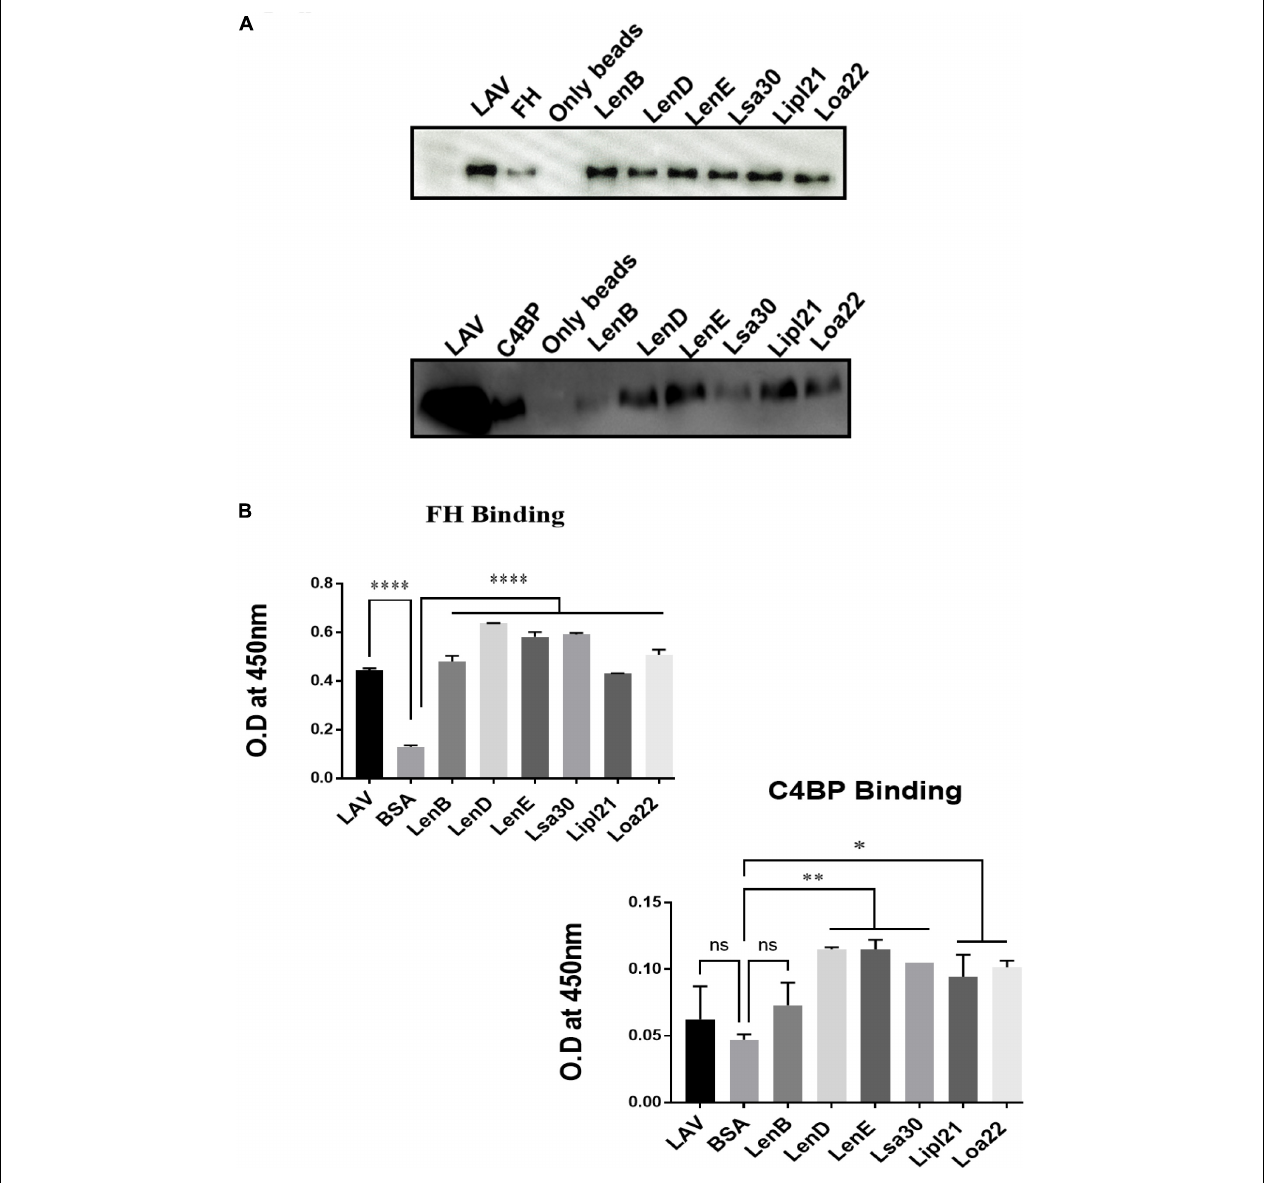
FIGURE 4 | Evaluation of binding of surface proteins with complement regulators (FH and C4BP). (A) Binding of surface proteins with FH and C4BP as analyzed by pull-down assay. Bead bound proteins (rLenB, rLenD, rLenE, rLsa30, rLipl21, rLoa22, or rLAV; 1 µ g each) or only beads were incubated with 10% HI-NHS, and protein–protein interaction was detected using anti-FH or anti-C4BP antibodies by Western blot as described in section “Materials and Methods”. (B) Binding of surface proteins as analyzed by ELISA. Microtiter plates were coated with proteins (1 µ g/ml) or BSA (negative control) followed by addition of 10% HI-NHS, and binding was detected with specific antibodies against FH and C4BP as described in section “Materials and Methods”. All data are representative of three different experiments. Significant differences were calculated using the one-way ANOVA ( ∗∗∗∗ , ∗∗ , ∗ , and ns indicates P < 0.0001, P < 0.01, P < 0.05, and non-significant,